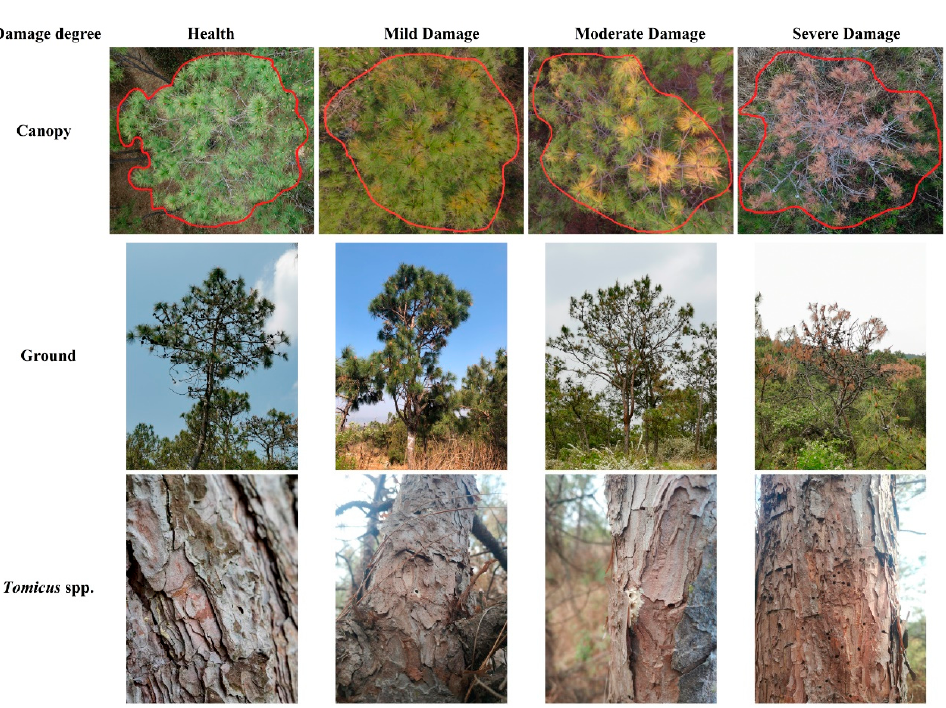
Figure 2. Example canopy